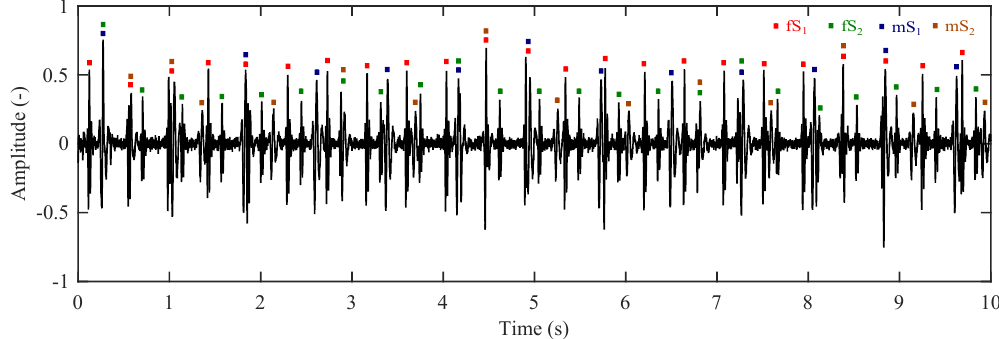
Figure 10. Input signal of the adaptive system formed by a mixture of maternal heart rate (mHR) and fetal heart rate (fHR).